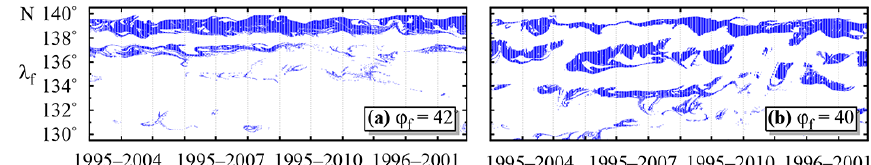
Figure 5. The T – λ f plots show when and at which longitudes the tracers, launched at the zonal line 37 ◦ N, eventually crossed the zonal lines